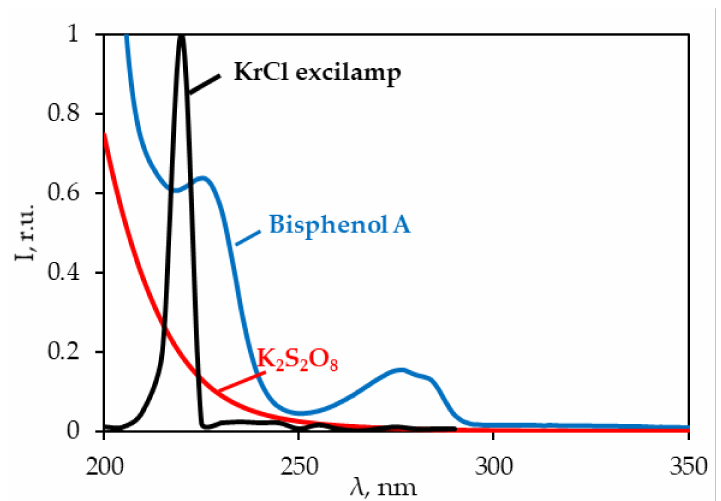
Figure 2. Absorption spectra of BPA and K 2 S 2 O 8 and the emission spectrum of the KrCl